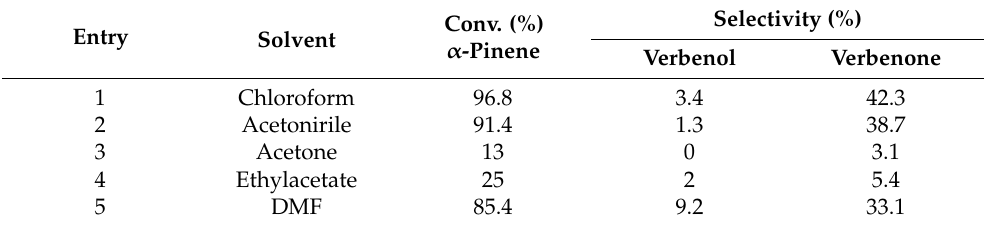
Table 4. Effects of different solvents on the synthesis of verbenenone from α -pinene 5 .